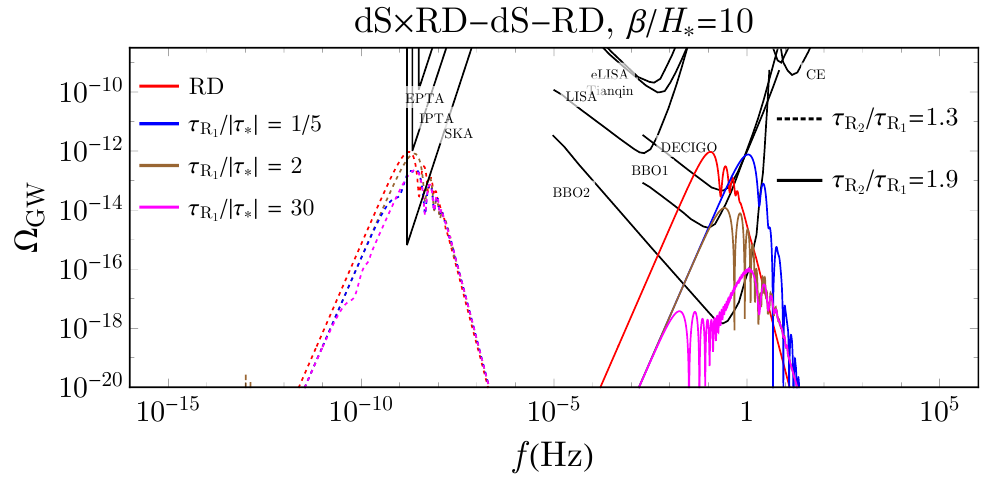
Figure 13 . The GW spectrum Ω GW in the dS × RD-dS-RD scenarios for different parameter sets. We choose β = 10 H inf , H inf = 10 12 GeV. The solid line is plotted using a ? /a end = exp( − 20) and the dotted line is with a ? /a end = exp( − 38) . τ R 2 − a R /a R 1 2